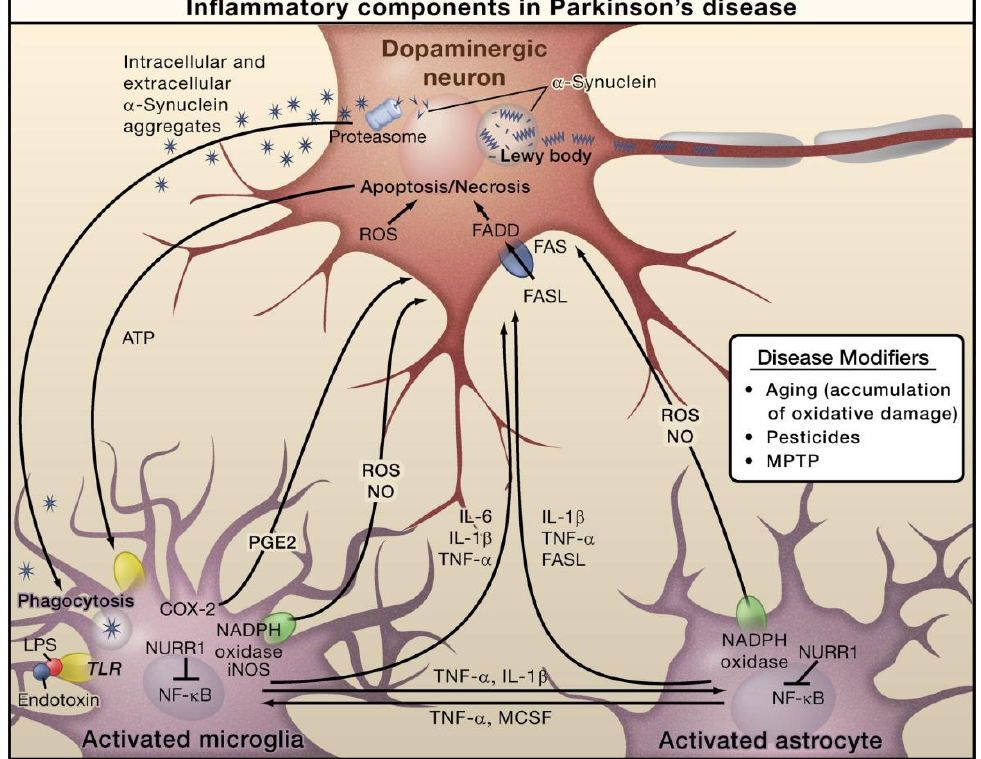
Figure 3. The role of inflammation mediators in the pathogenesis of Parkinson’s disease. Reproduced with permission from Elsevier [47].